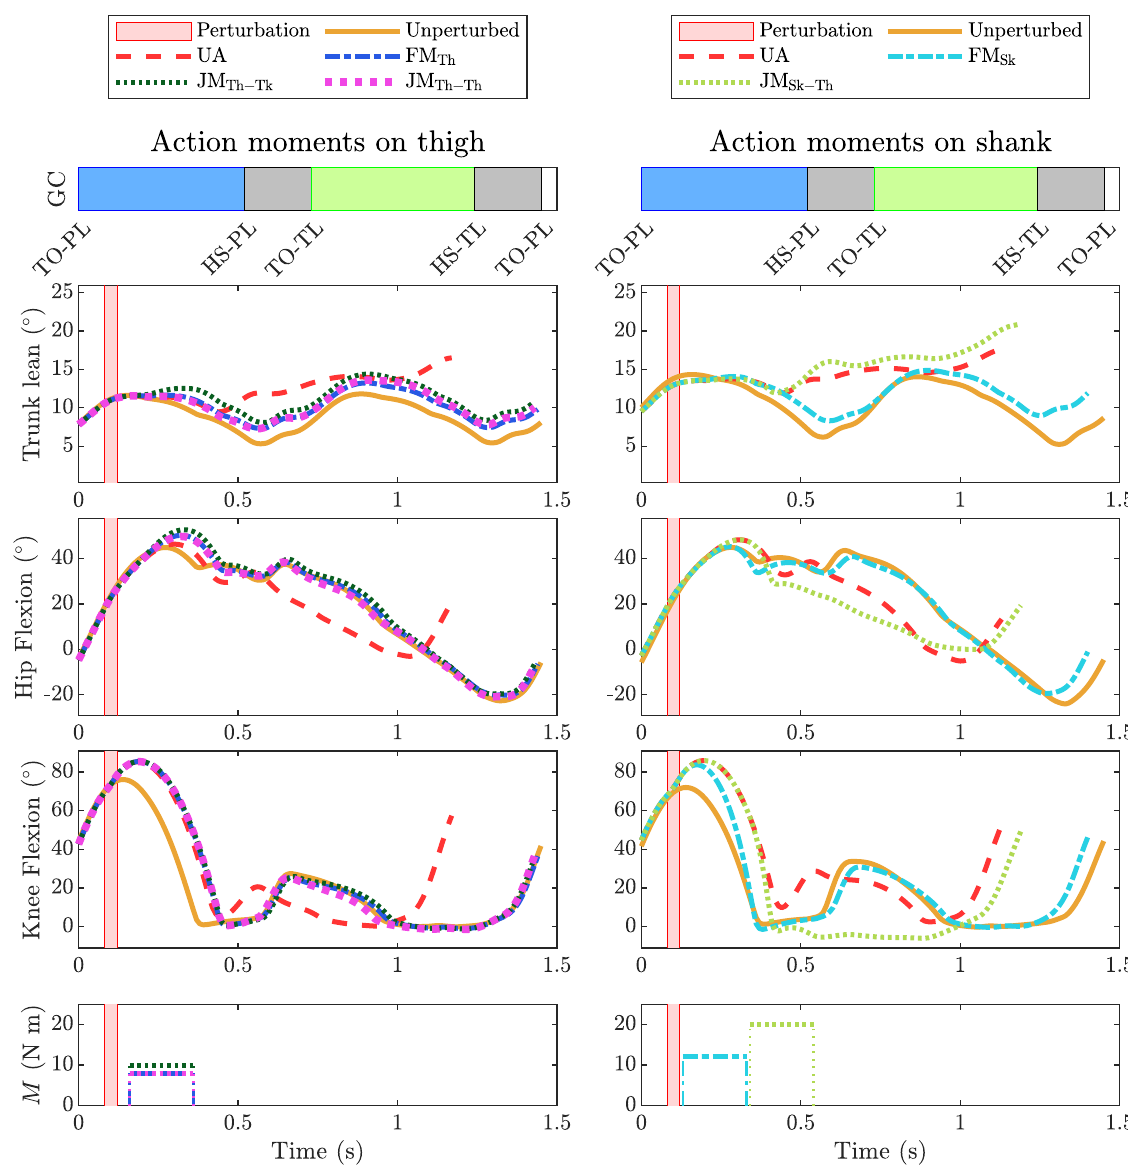
Fig 6. Kinematic response to perturbation P1. Left column: Assistance via hip flexion of the perturbed limb. Conditions denoted by lines are unperturbed (UP), unassisted (UA), free moment with action on thigh (FM Th ), joint moment with action on thigh and reaction on trunk (JM Th-Tk ), and joint moment with action on thigh and reaction on contralateral thigh (JM Th-Th ). Right column: Assistance via knee extension of the perturbed limb. Conditions denoted by lines are unperturbed (UP), unassisted (UA), free moment with action on shank (FM Sk ), joint moment with action on shank and reaction on thigh (JM Sk-Th ). Individual plots show the trunk lean angle, hip flexion angle, and knee flexion angle, and applied moment M as a function of time. Bar graphs at top of each column show the gait events of the unperturbed gait cycle (GC), where TO-PL and HS-PL are toe-off and heel-strike events of the perturbed limb, and, TO-TL and HS-TL are toe-off and heel-strike events of the trailing limb. knee extension angle, as it follows the same trend for all cases; as seen in response to P2, all case of thigh assistance have a different assistance magnitude but no difference can be seen in the knee extension angle (S1 Fig). A slight difference is visible in P4, where one may notice the delayed knee extension (Fig 7) which is the result of delayed start of assistance. Moments